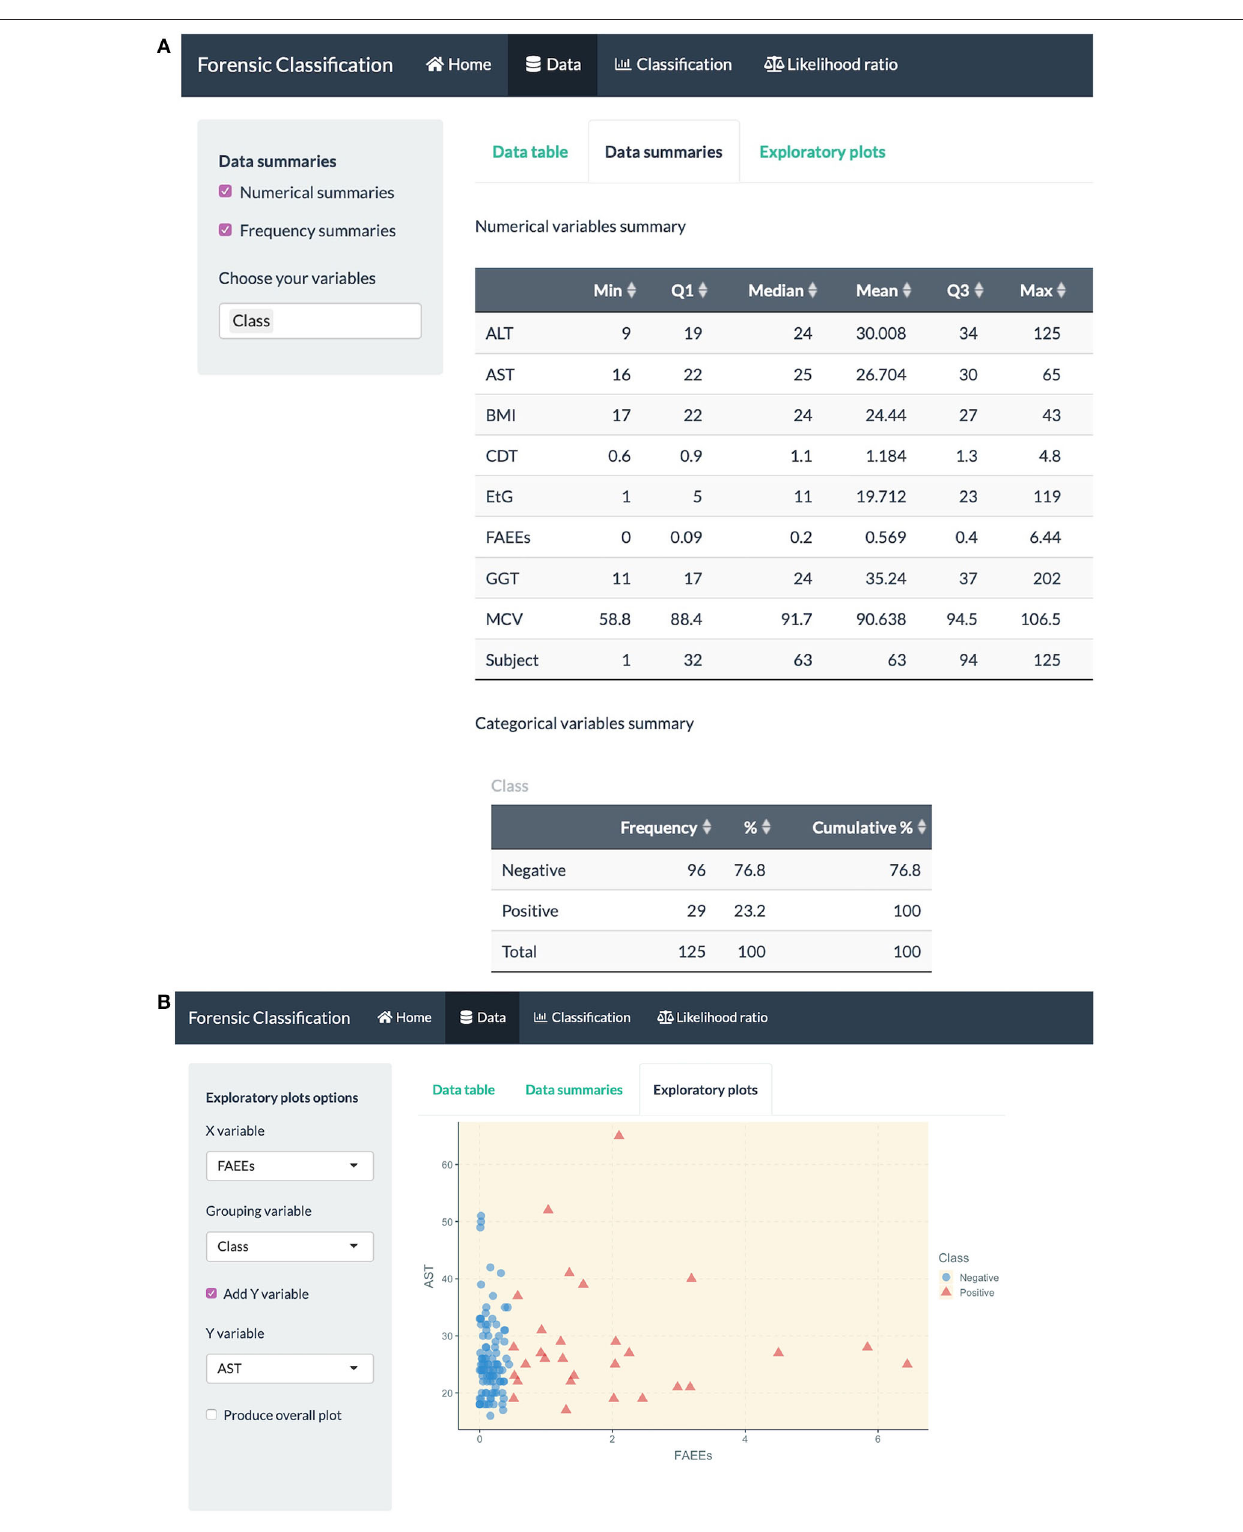
Frontiers in Chemistry |